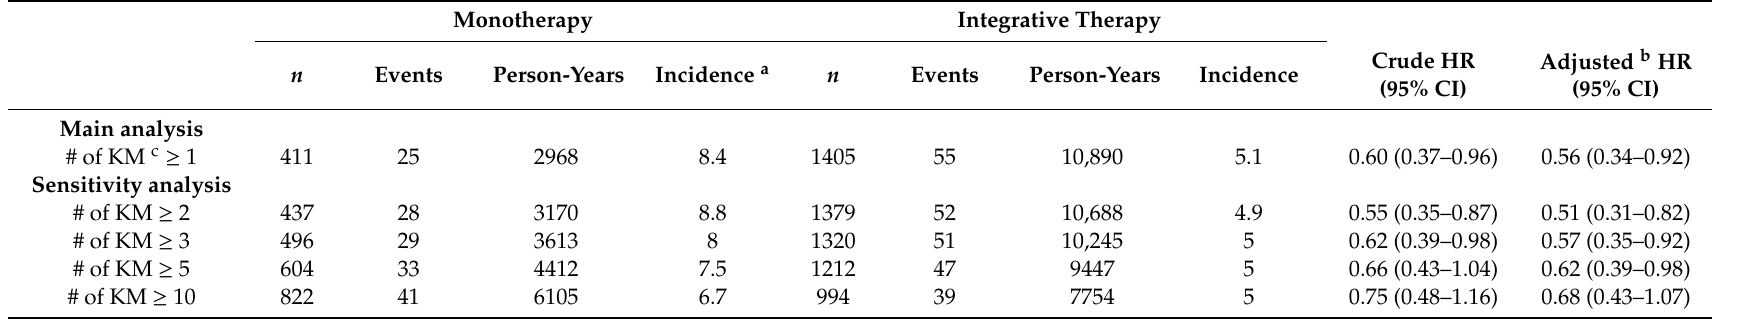
Table 3. Risk of PD in patients with IBD according to the number of KM